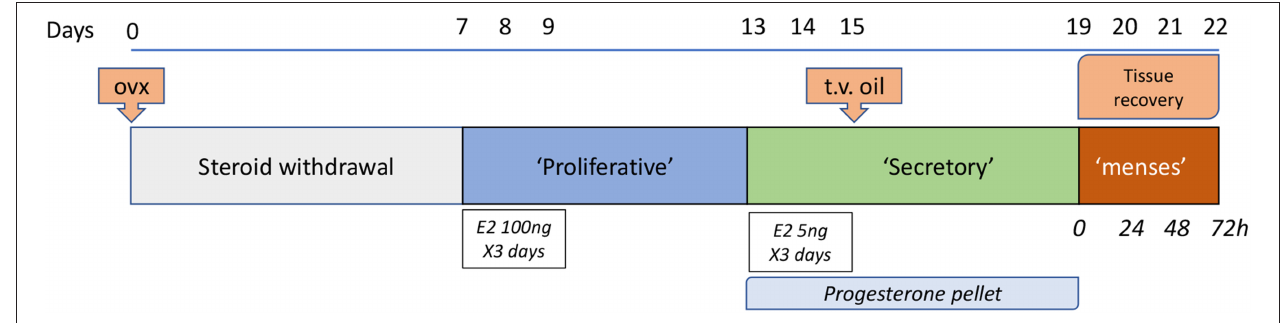
FIGURE 1 | Edinburgh Mouse model of menstruation. This model is based on the pioneering work of Finn and Pope (29) with several refinements including the use of a progesterone pellet (32) and induction of decidualization via a trans-vaginal [t.v.; (3)] route. Samples are recovered on day of pellet removal (time 0, full decidualization) and at times thereafter between 4 and 72h. Twenty four hours after pellet withdrawal has been characterized as a time of maximal tissue breakdown but by 48h the epithelial layer surrounding the uterine lumen is typically fully